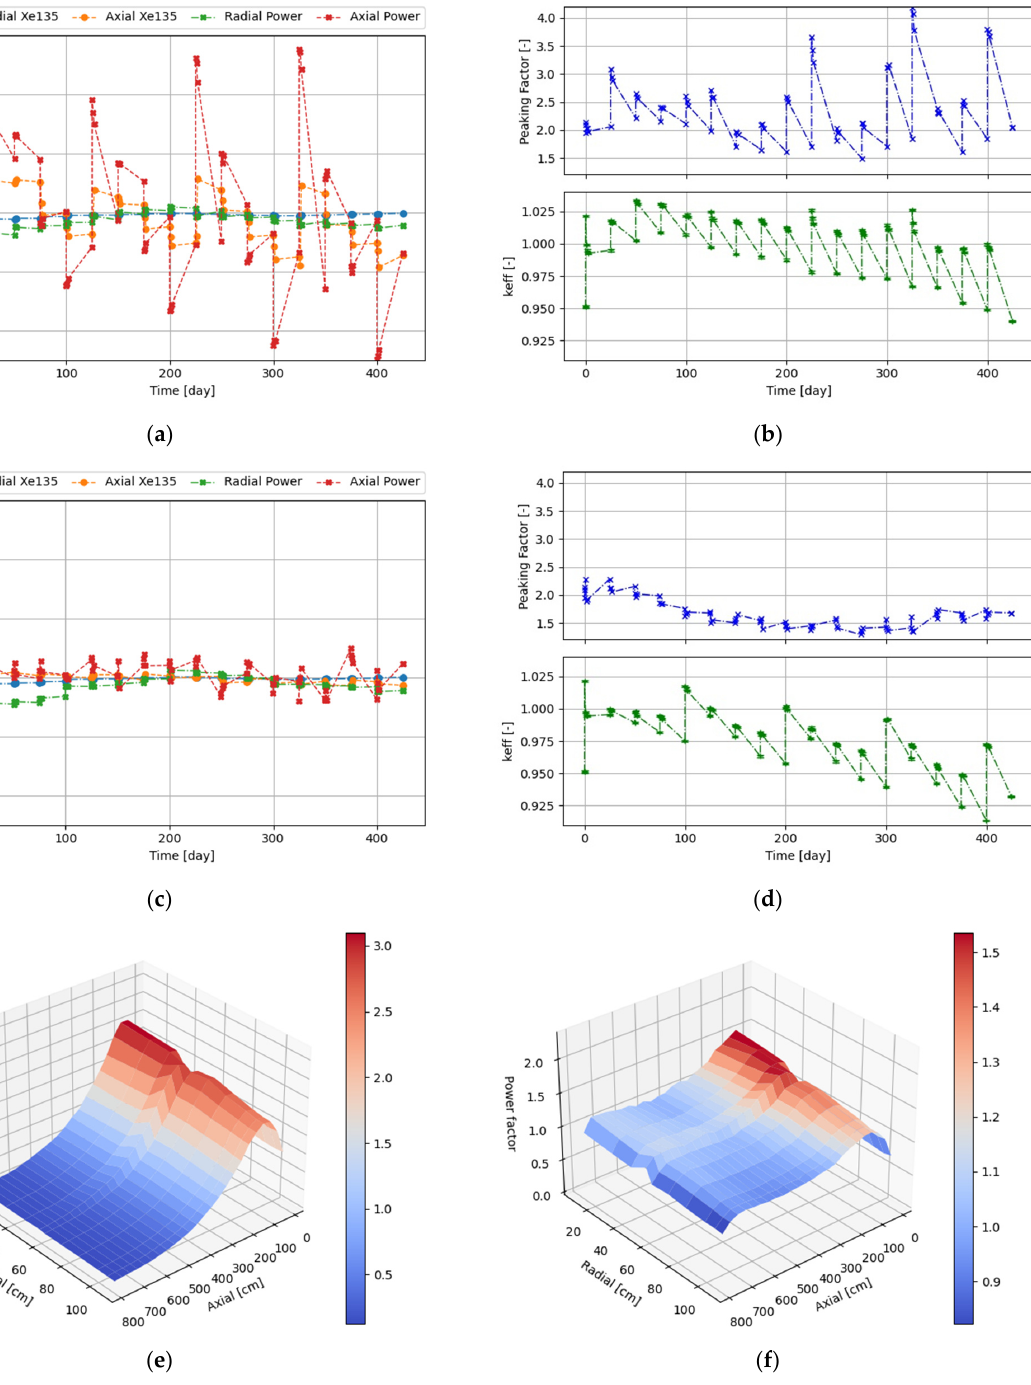
Figure 5. Results of radial layer application investigation: ( a ) distribution parameters in St_solid; ( b ) peaking factor (top) and k eff (bottom) evolution in St_solid; ( c ), distribution parameters in St_struc; ( d ) peaking factor (top) and k eff (bottom) evolution in St_struc; ( e ) power profile at day 300 after control rod operation in St_solid; ( f ) power profile at day 300 after control rod operation in St_struc.